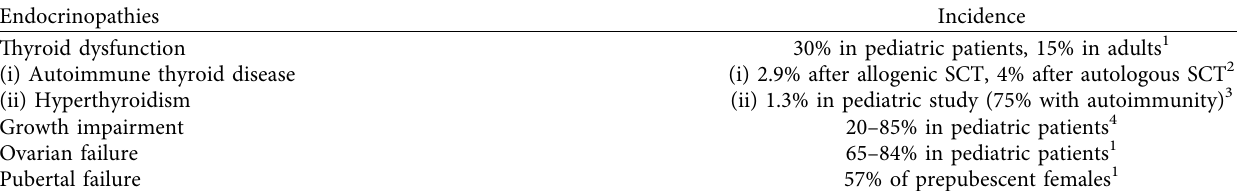
Table 1: Endocrinopathies after stem cell